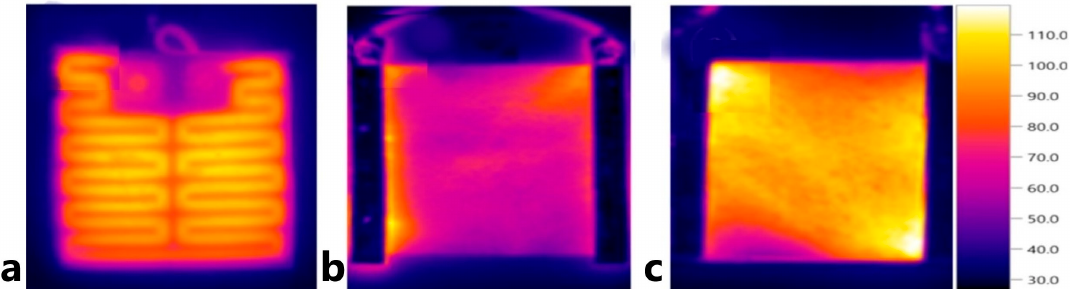
Figure 14. Infrared images of ( a ) NiCr, ( b ) CFs, and ( c ) CFP-2700 heating elements (Reprinted with